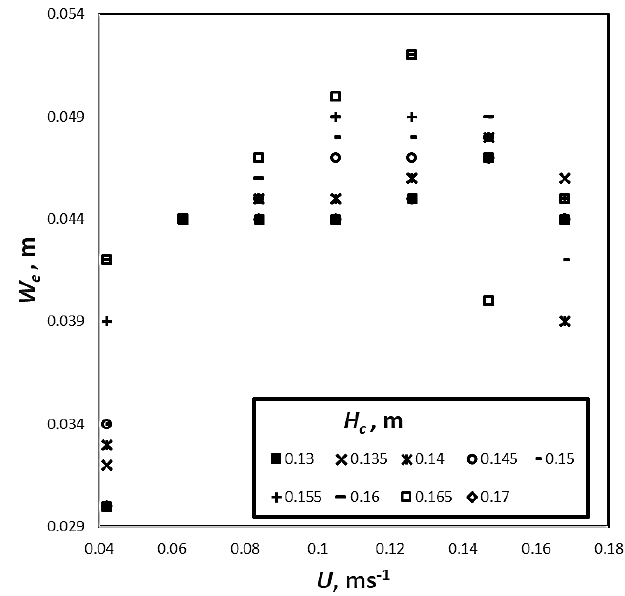
Figure 9. Variation of W e with U and H c.